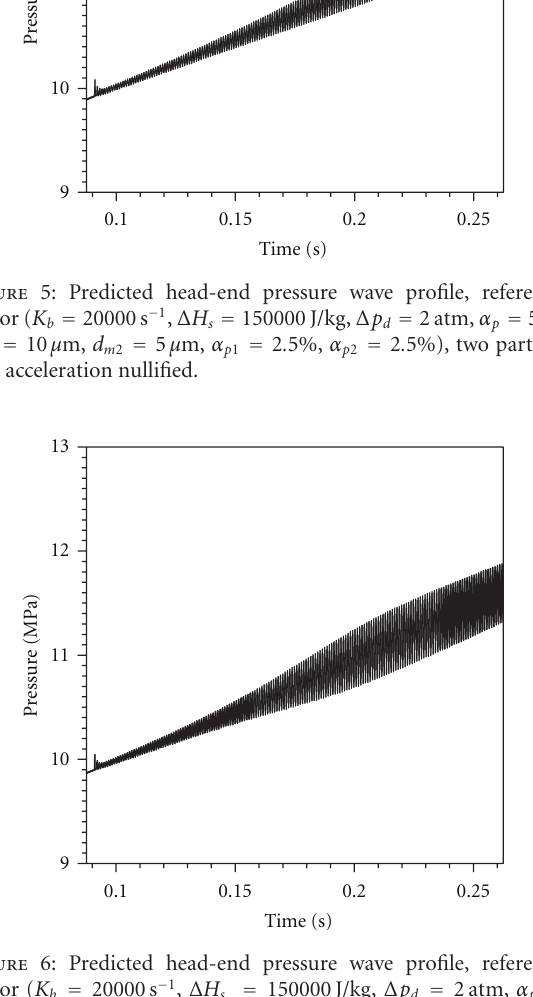
Figure 4: Predicted head-end pressure wave profile, reference motor ( K b = 20000 s − 1 , Δ H s = 150000 J/kg, Δ p d = 2 atm), acceleration nullified, 5% 10- μ m Al particle loading by mass, single particle set.